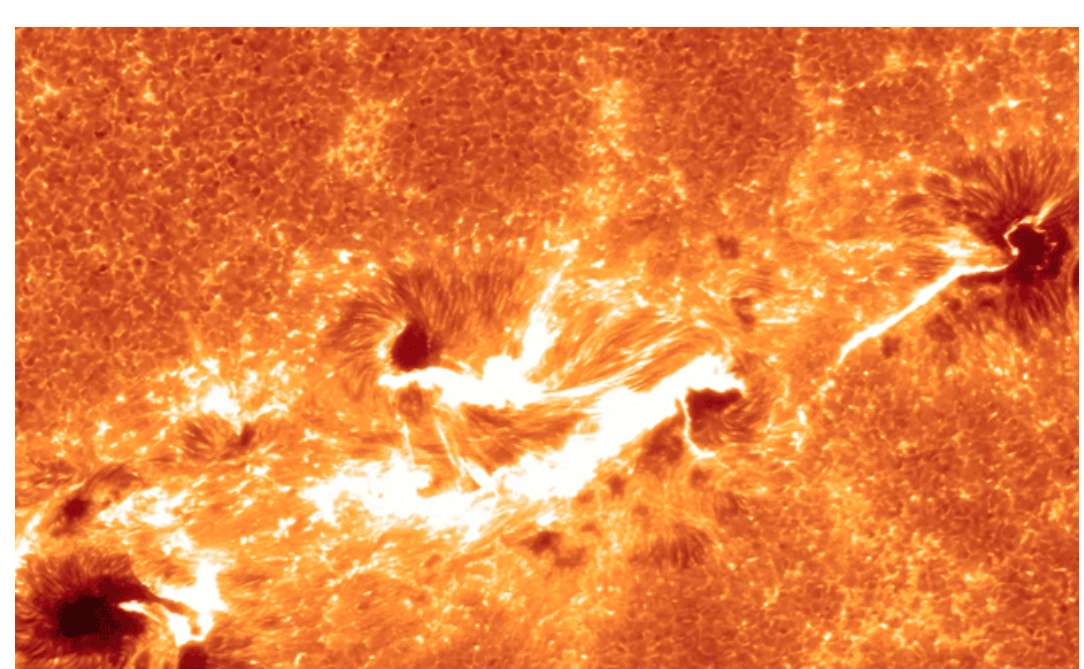
Figure 3: Hinode/SOT Ca ii H observation of NOAA AR 11158, which produced a series of M and X-class flares as it emerged into the solar atmosphere. This particular image shows the flare ribbons and post-flare loops after the X-class flare on Feb. 15, 2011 (Image credit: Joten